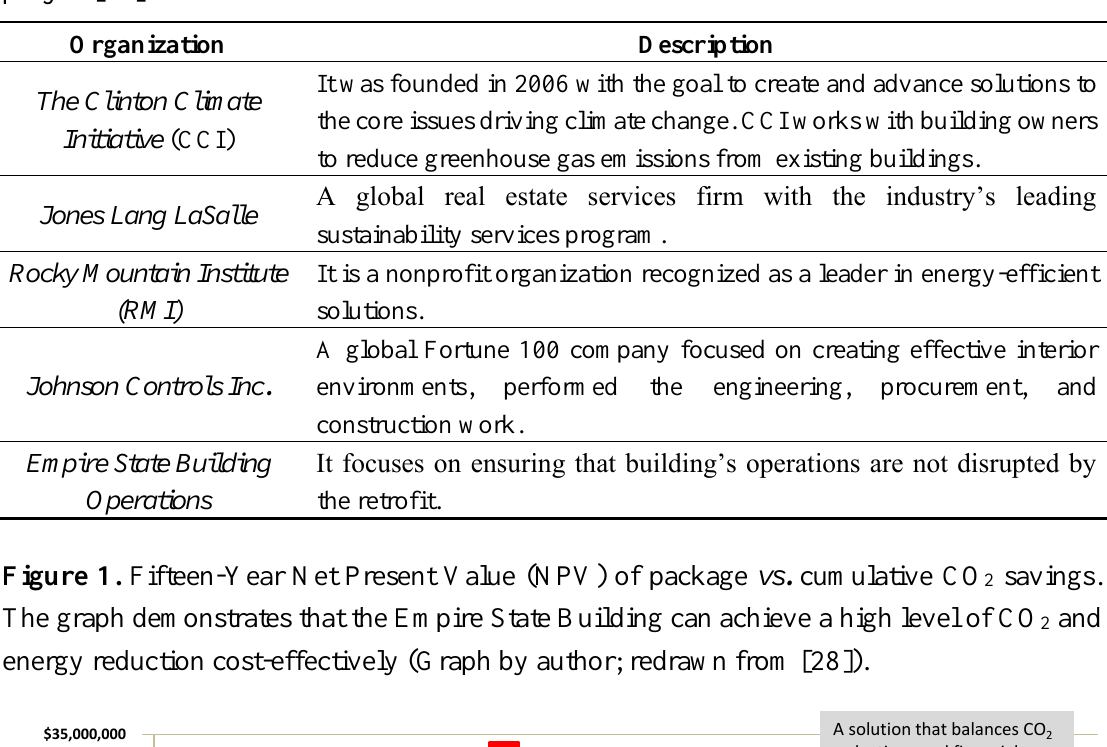
Table 1. Organizations that were involved in the Empire State Building’s retrofit project [28].